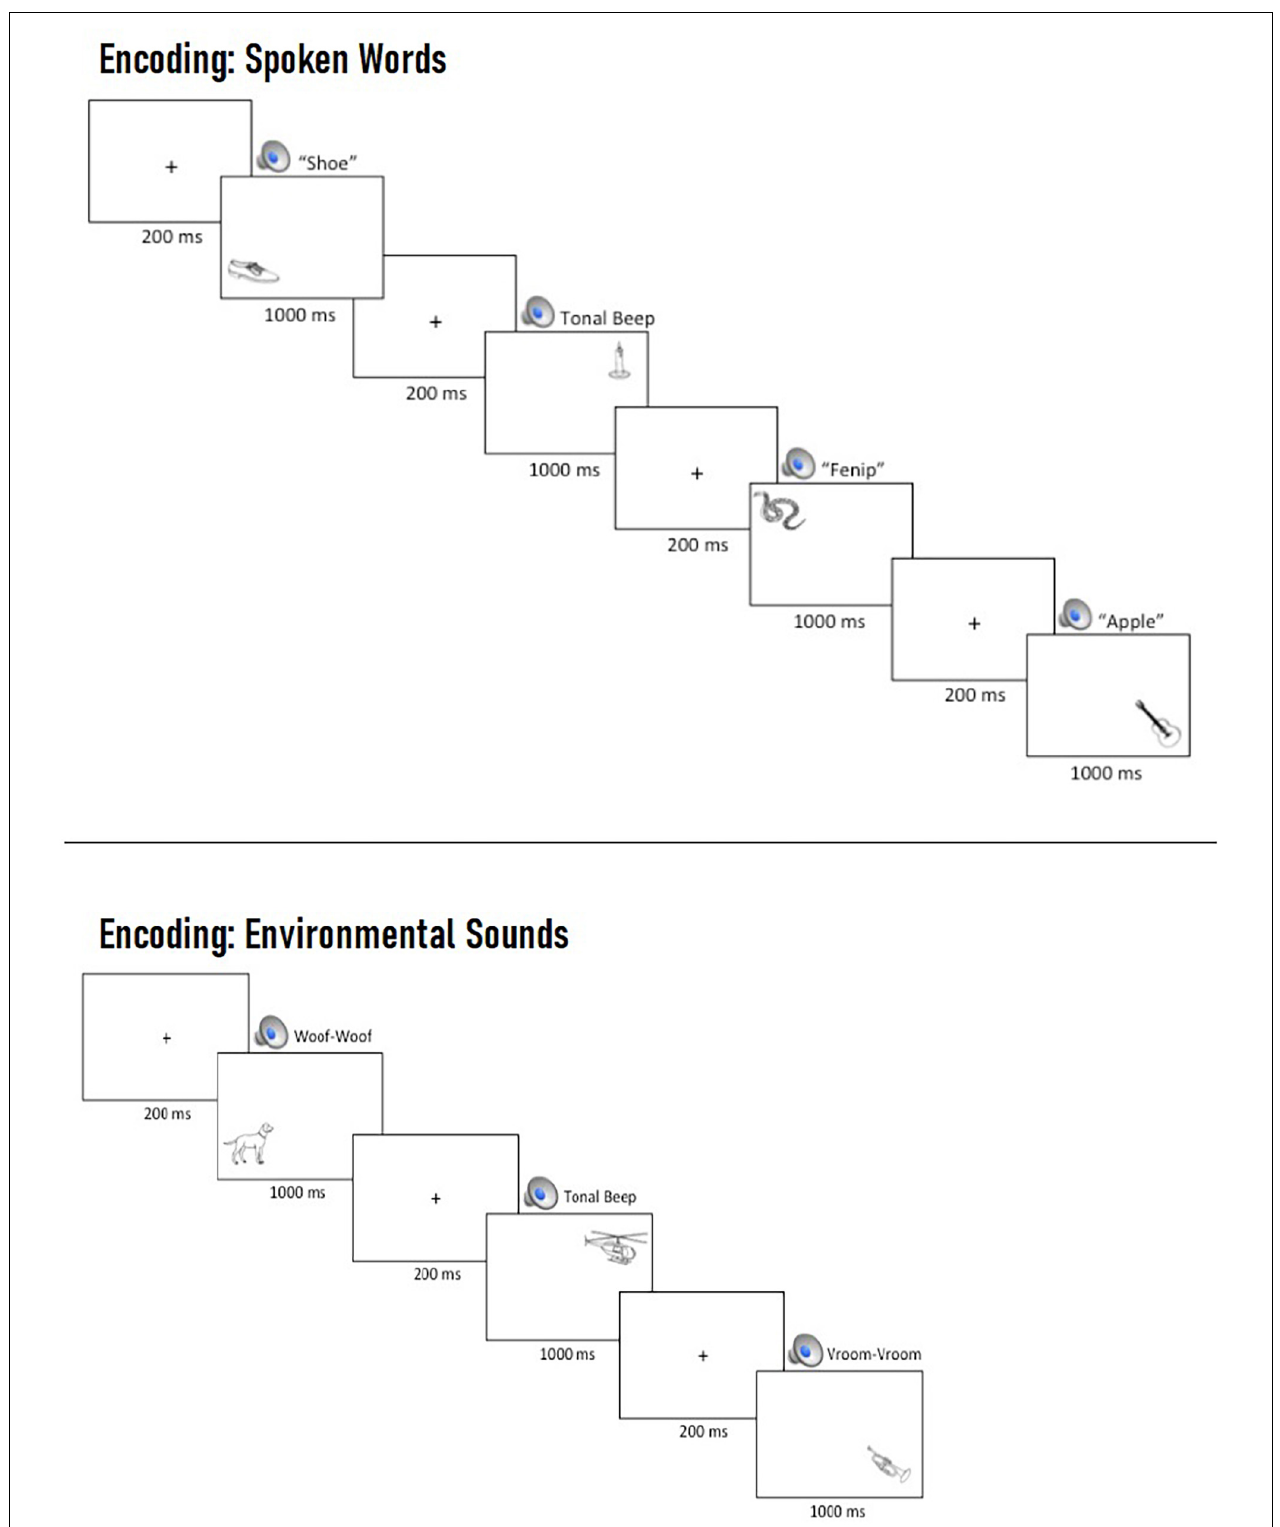
FIGURE 2 | Example multi-trial run of spoken words (Top) and environmental sounds (Bottom) during encoding. On each trial, participants were presented with a central fixation cross for 200 ms, which was replaced by the concurrent presentation of a task-irrelevant, spatially uninformative auditory cue and a picture in one of four locations, which remained on screen for 1,000 ms prior to the beginning of the next trial.